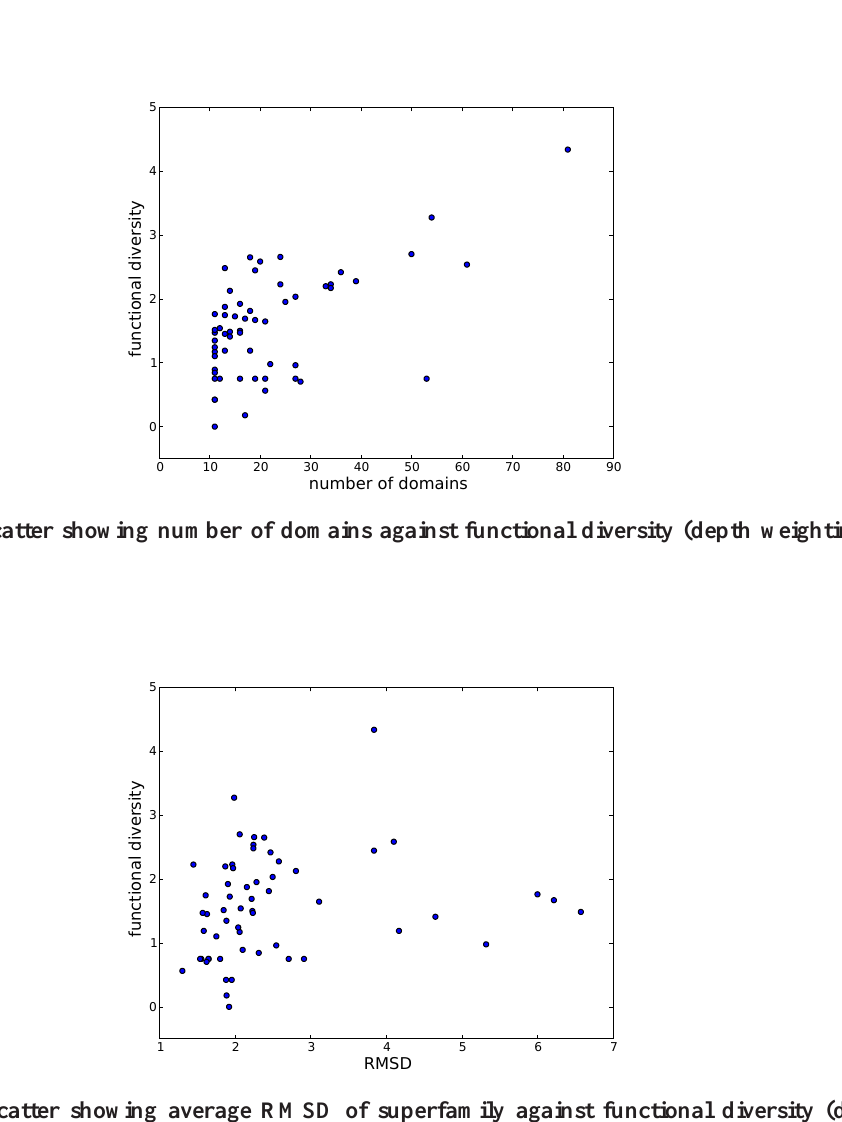
Figure 3: Histogram showing numbers of superfamilies with a given functional diversity (depth weighting of 0.75)